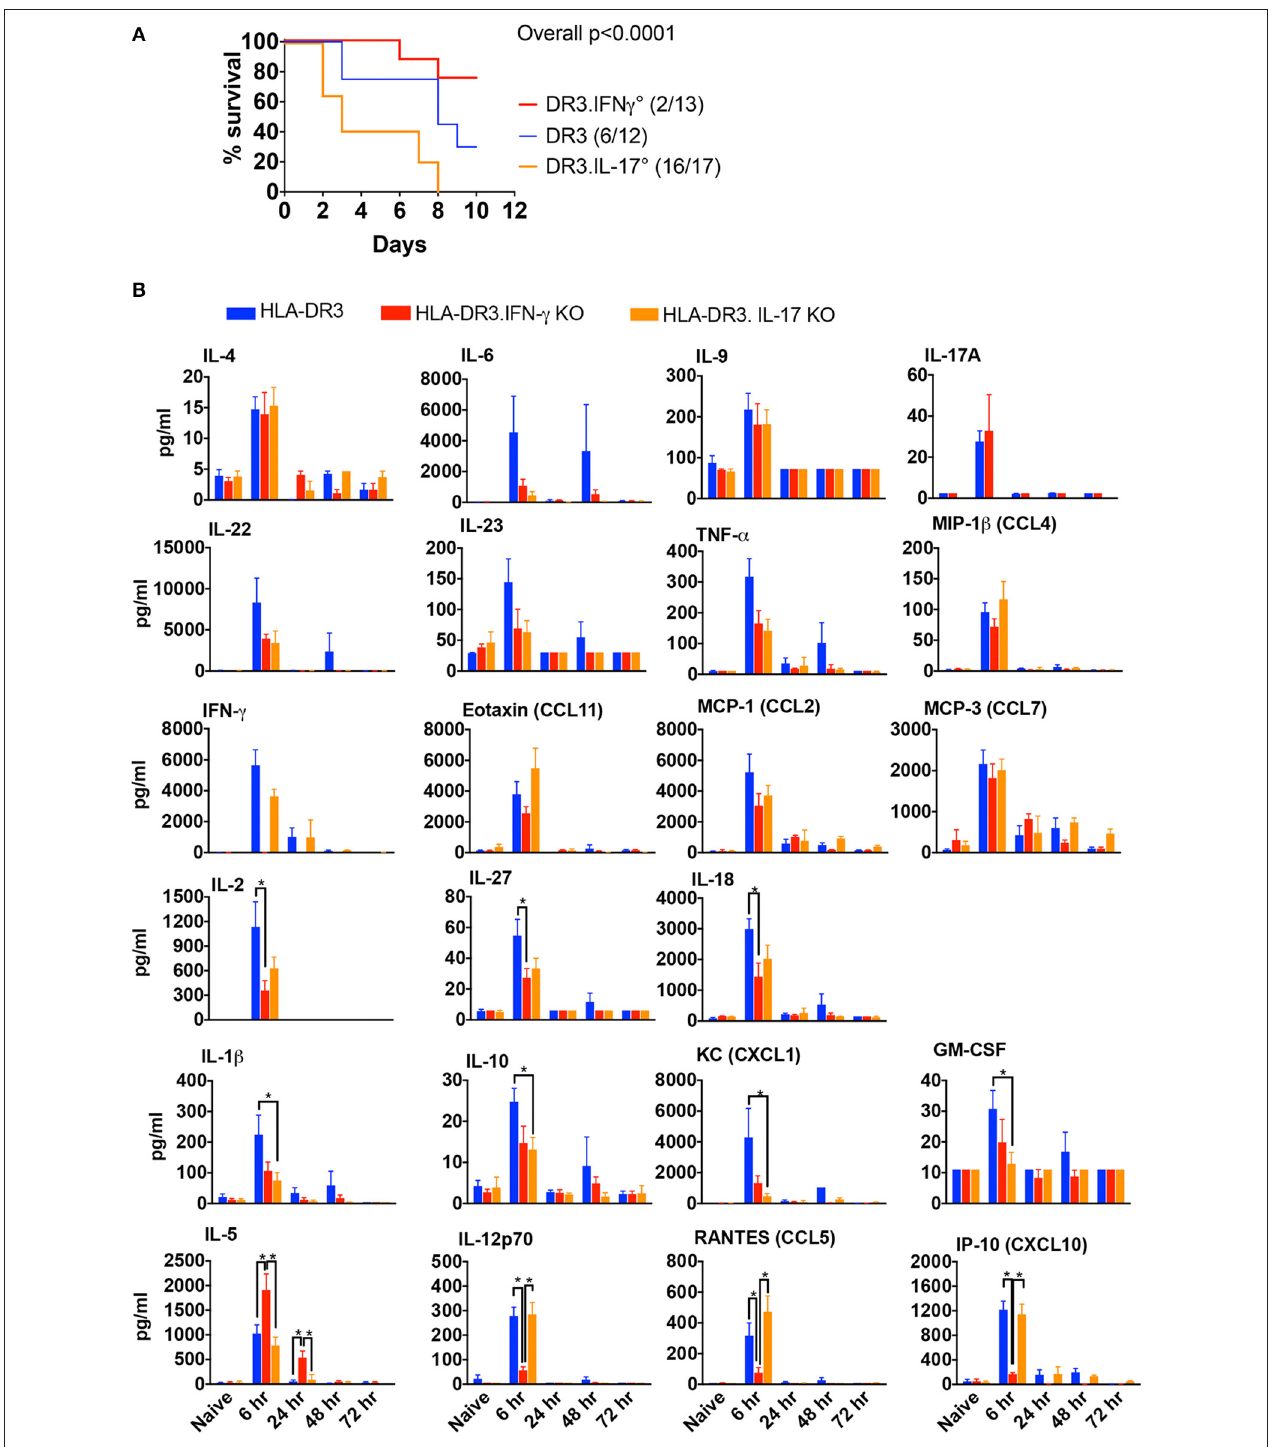
FIGURE 1 | SAg-induced, T cell driven-CRS in HLA-DR3 mice and the impact of IFN- γ and IL-17-deficiency. (A) Mortality HLA-DR3.WT, DR3.IFN- γ ◦ , and DR3.IL-17 ◦ mice were challenged with 50 µ g of SEB in 200 µ l of PBS by intraperitoneal route. Mice were monitored frequently as per IACUC recommendations. Moribund animals and other animals that met the criteria for humane endpoints were removed from the study and euthanized. Survival curves were plotted using graphpad prism. Figures in parenthesis indicate the number of animals that succumbed over total number of mice used. (B) Cytokine signature mice challenged as in (A) were euthanized at indicated time points and blood collected by cardiac puncture. Concentrations of a panel of cytokines and chemokines in individual serum samples were determined using multiplex bead assay. Each bar represents mean ± SE from 3 to 10 mice. * p < 0.05.